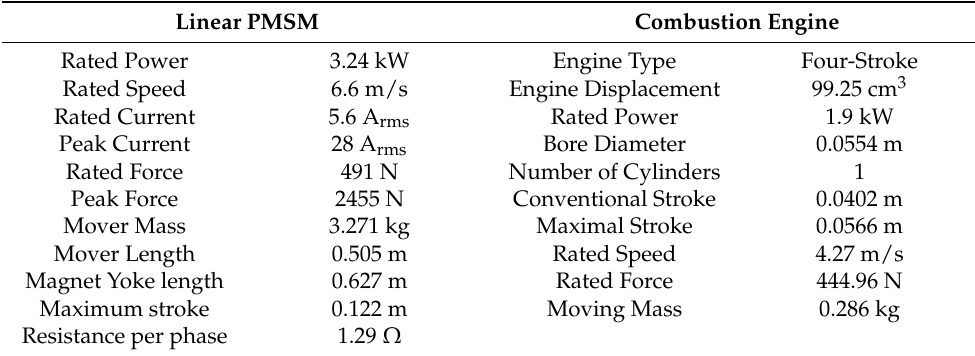
Table 1. Characteristic data of the test